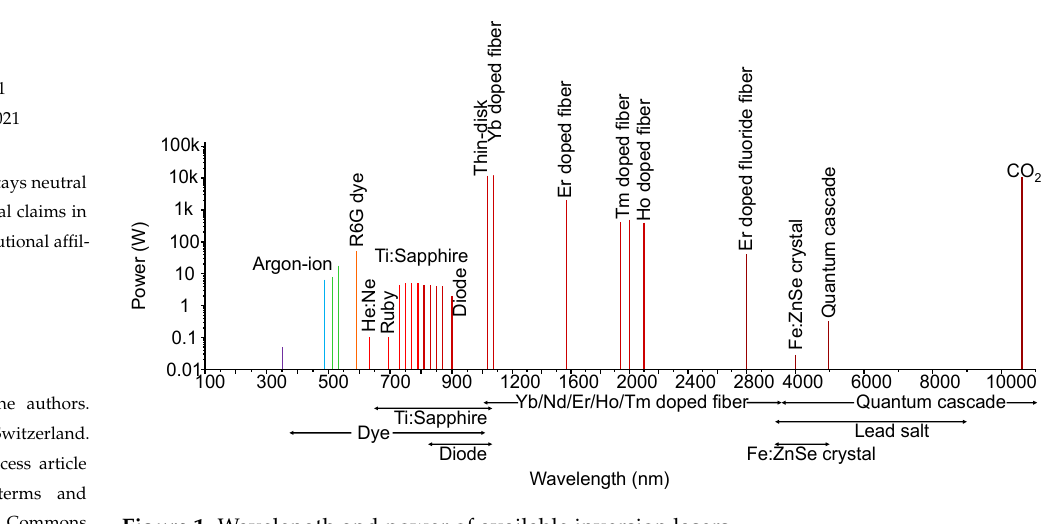
Figure 1. Wavelength and power of available inversion lasers.